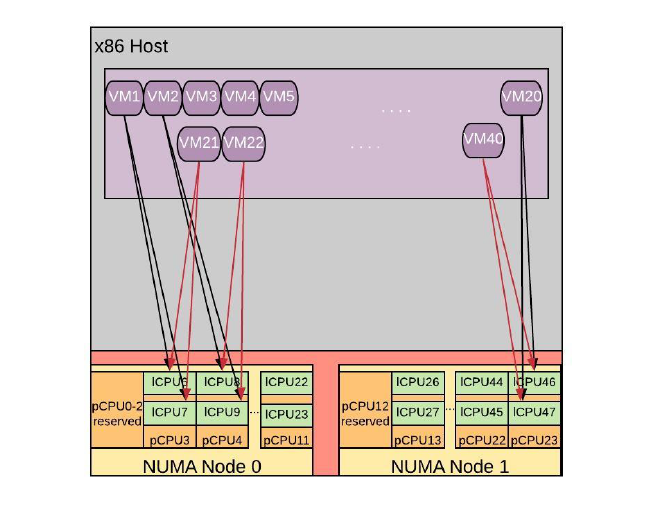
Figure 9. CPU allocation in a 4:1 oversubscribed